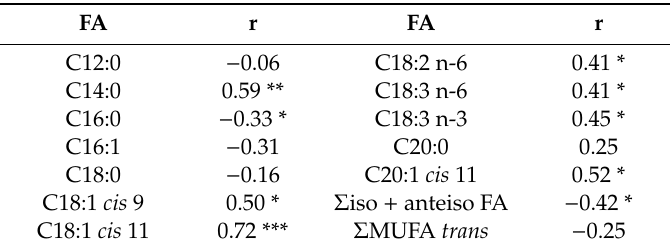
Table 9. Correlations among the fatty acid concentrations in black soldier fly prepupae (BSFPs) and the fatty acid concentrations in their diets. FA r FA r C12:0 − 0.06 C18:2 n-6 0.41 * C14:0 0.59 ** C18:3 n-6 0.41